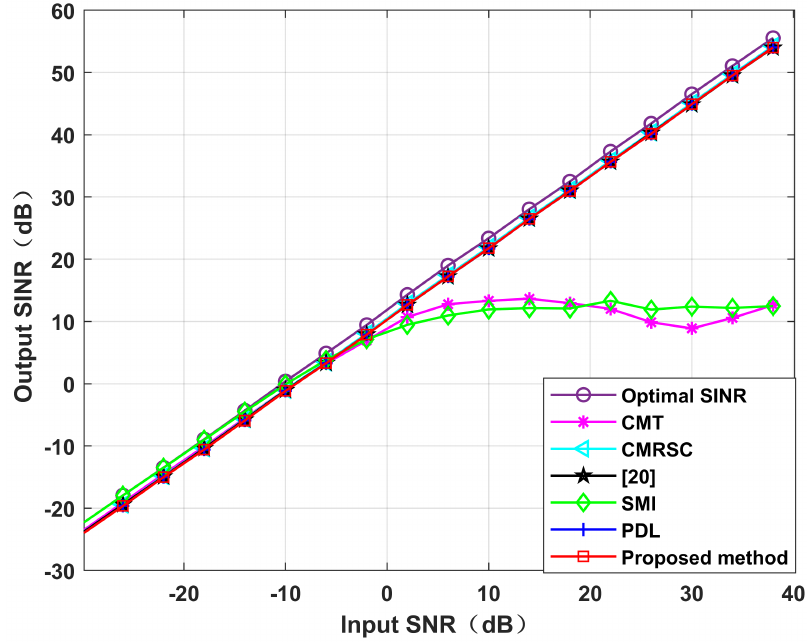
Figure 12. Output SINR under different input SNR conditions. Simulation 5.